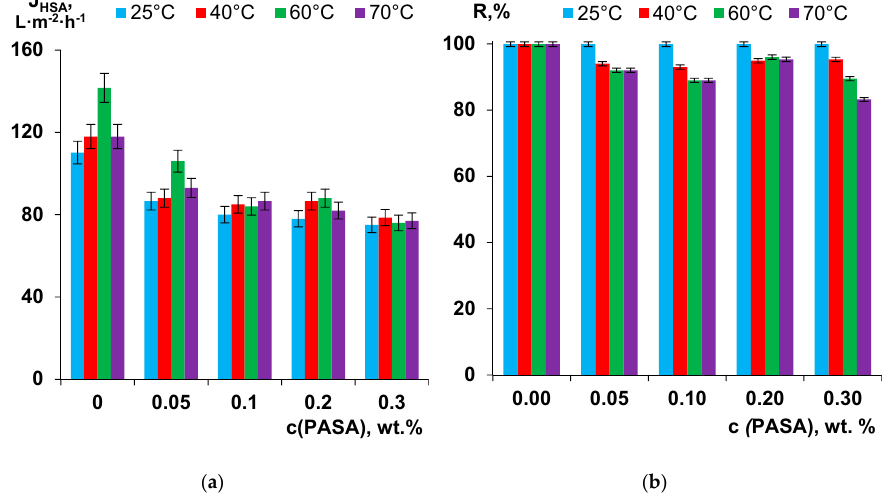
Figure 10. Dependence of pure water flux (PWF; measured at trans-membrane pressure of 1 bar) on PASA concentration in the coagulation bath at different coagulation bath temperatures, T, °C: 1—25; 2—40; 3—60; 4—70.